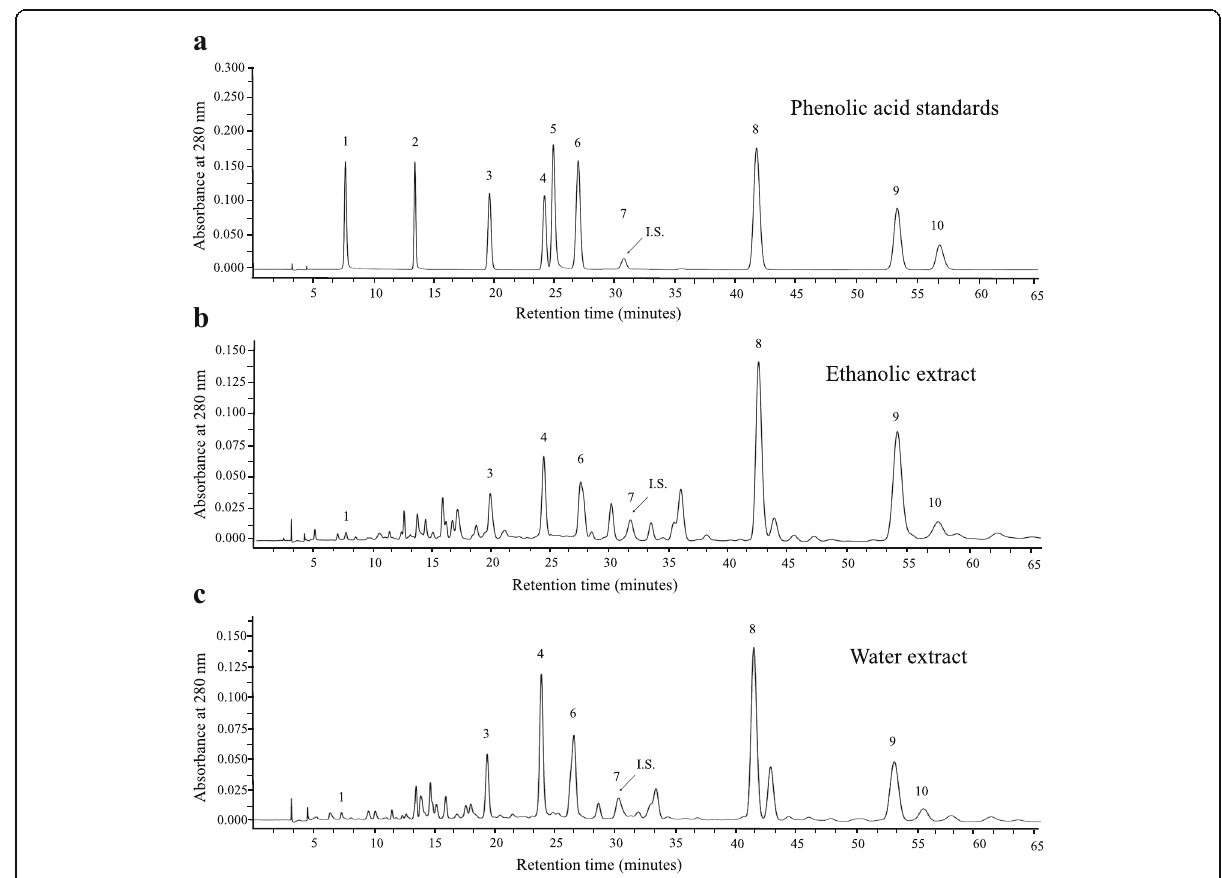
Fig. 7 HPLC chromatograms of phenolic acid standards ( a ), base hydrolyzed ethanolic ( b ) and water ( c ) extracts of the powdered formula of H. cordata fermented broth and P. emblica fruit where 1 = gallic acid, 2 = protocatechuic acid, 3 = p -hydroxybenzoic acid, 4 = vanillic acid, 5 = cafeic acid, 6 = syringic acid, 7 = p -hydroxybenzaldehyde, 8 = p -coumaric acid, 9 = ferulic acid and 10 = sinapinic acid. p -Hydroxybenzaldehyde was used as an internal standard (I.S.)